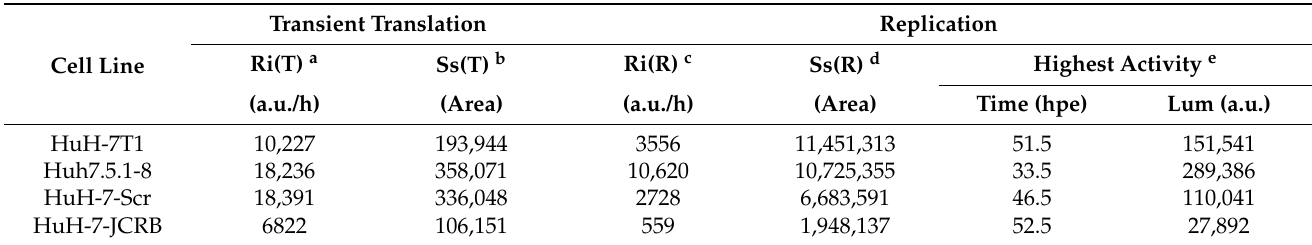
Table 1. Comparison of bioluminescence profiles of transient translation and replication in HuH-7 derived cell lines.